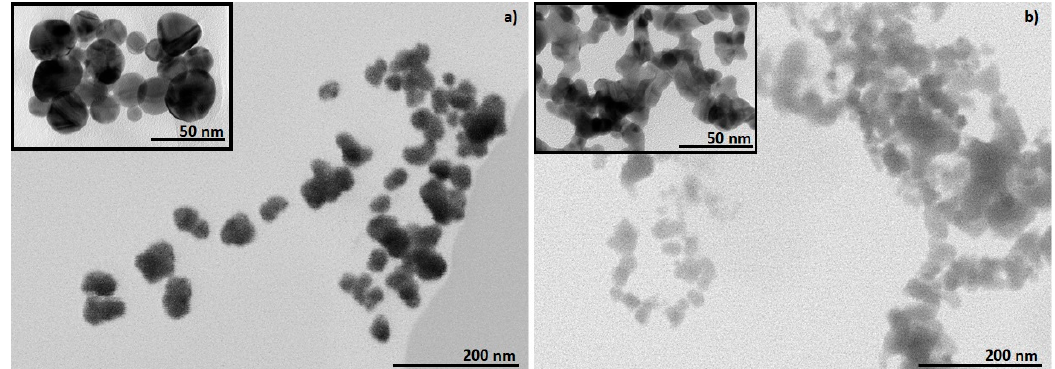
Figure 2. STEM images of colloidal AuNPs, with inserted TEM images: ( a ) AuCl and ( b ) AuAc.